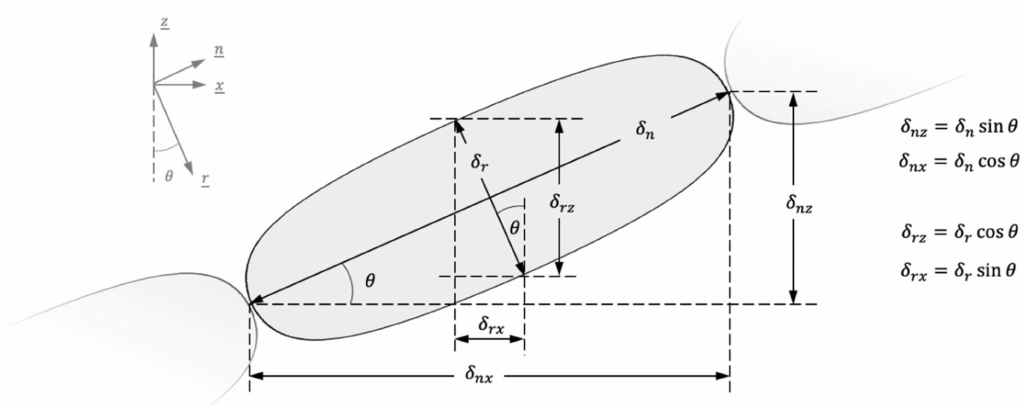
Figure 3. The projection of resolutions along look angle ( r ) and perpendicular to look angle ( n ) onto vertical ( z ) and horizontal ( x ) axes depending on look angle and the relative size of resolutions.